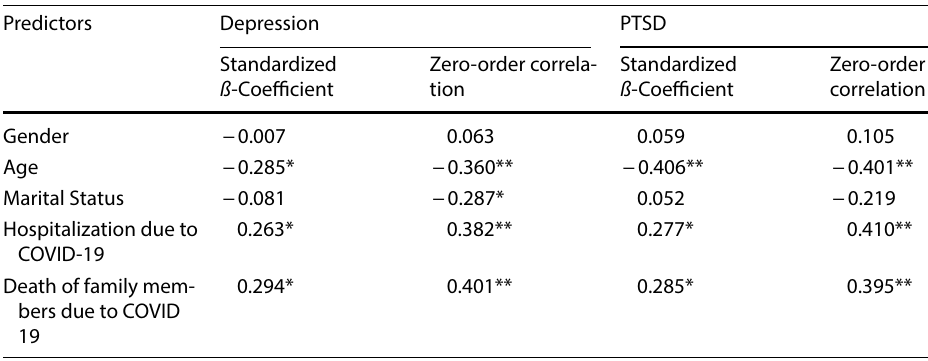
Table 1 Predictors of mental health